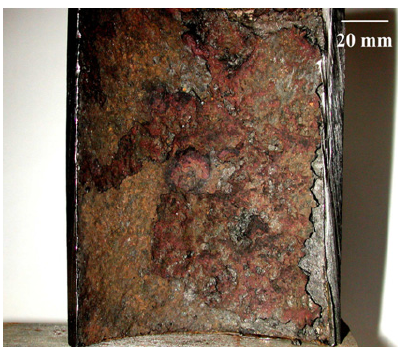
Figure 6: Macrographic analysis. Magnification of a detail from Fig. 4. Corrosion scale.